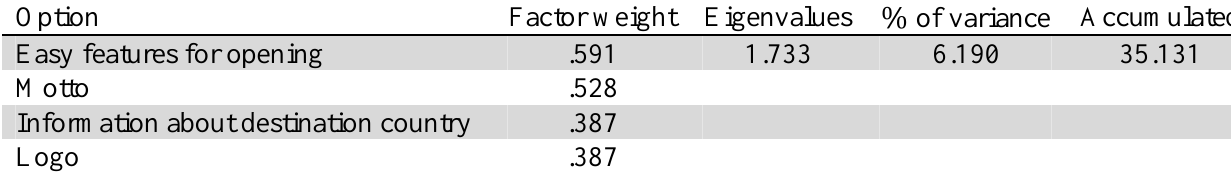
The summary of factors impacting communication with consumers Option Easy features for opening Information about destination